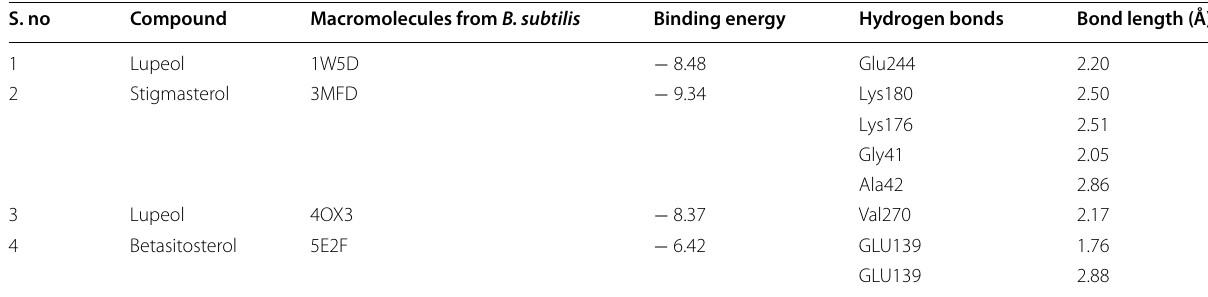
Table 2 Compounds from Syzygium cumini having high affinity for macromolecules from Bacillus subtilis S. no Compound Macromolecules from B.